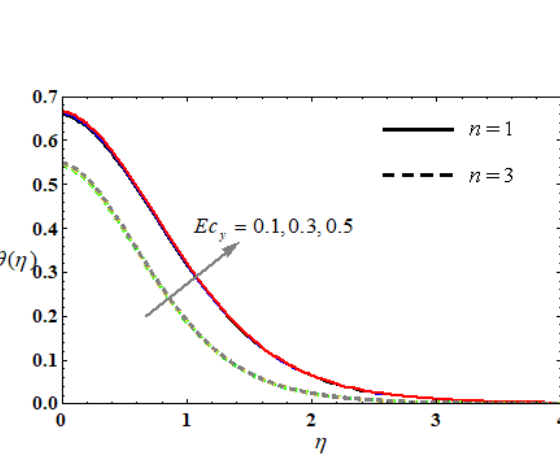
Fig. 19: Influence of Ec x on θ ( η )